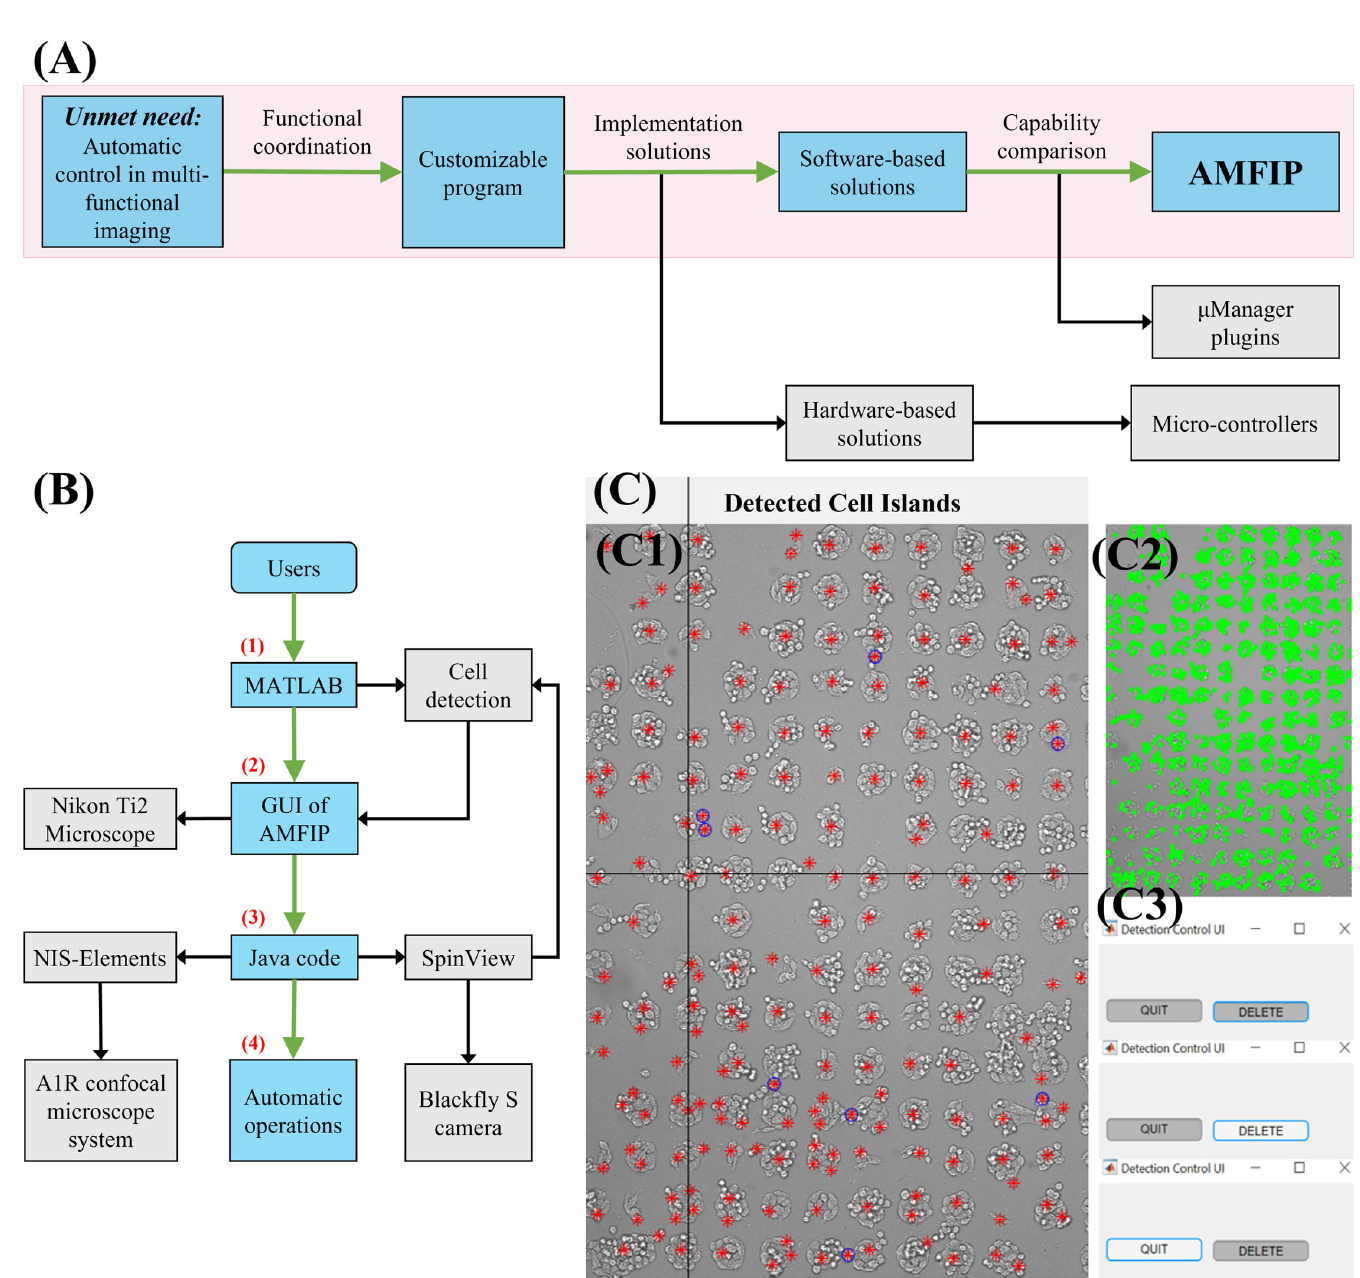
Fig 1. The design of automatic multi-functional integration program (AMFIP). ( A ) Software-based AMFIP is designed and developed to achieve customizable and automatic control of generic microscopy systems. This capability is needed in many research laboratories. AMFIP enables automatic, customizable, and hardware- independent control (in blue) of multi-functional imaging conditions to acquire spatial-temporal biological information. In contrast, other software-based solutions (in grey), such as μ Manager plugins, and hardware-based solutions, such as micro-controllers, only control limited hardware and thus provide restricted functions. ( B ) The Workflow of implementing AMFIP in a typical experiment. (1) A custom MATLAB program assists in detecting the cells of interest and generates a coordinate list of selected FOVs. (2) The GUI of AMFIP reads the coordinates to guide the movement of the XY motor-stage. Users input pre-defined experimental parameters and initiate μ Manager to modulate the Nikon Ti2-E microscope. (3) Java code in AMFIP activates Elements and SpinView to manipulate the A1R confocal microscope system and Blackfly S camera. The MATLAB program reads the latest bright-field image to update the coordinates of current FOVs. (4) AMFIP automatically conducts these operations in sequence for multi-functional imaging. ( C ) A representative view of MATLAB operation interface for automatic cell detection and stage-drift prevention. ( C1 ) The Interface of MATLAB to edit marks of detected cell islands. Red marks indicate the centroids of detected cell islands while blue circles denote unwanted marks. The mis-match rate (number of marks that are not cell divided by number of overall marks) is 4.66% ± 0.82%. ( C2 ) Patterns of detected cells. The detected cells are marked with green rectangles. ( C3 ) Detection control with “DELETE” and “QUIT” buttons. The button in grey indicates that its statement is inactivated. By clicking the button, its function is